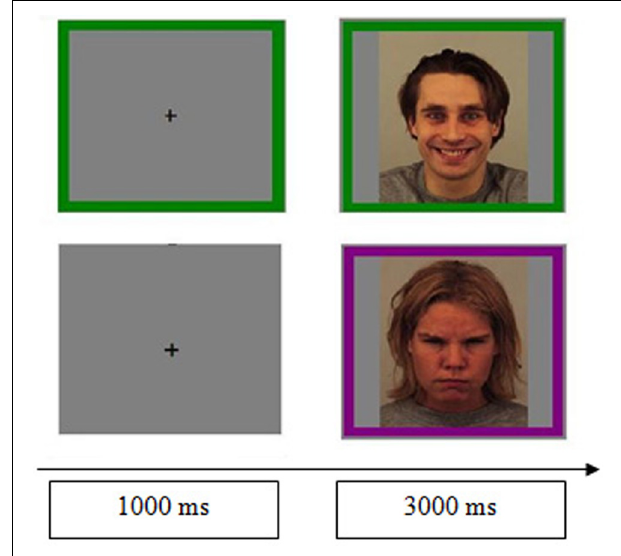
FIGURE 1 | Sequence of events in two trials. In the upper example, which illustrates the preparation condition, the fixation point is surrounded by a signal that anticipates the task. After 1000 ms, a picture of a happy man (AM25HAS) appears for 3 s, surrounded by a green frame. In the lower example (i.e., the no preparation condition), the target, an angry woman (AF25ANS) surrounded by a purple frame, is not preceded by any signal. The color of the frame indicates the demand to perform, which is to identify either the gender or the emotion of the face, depending on the